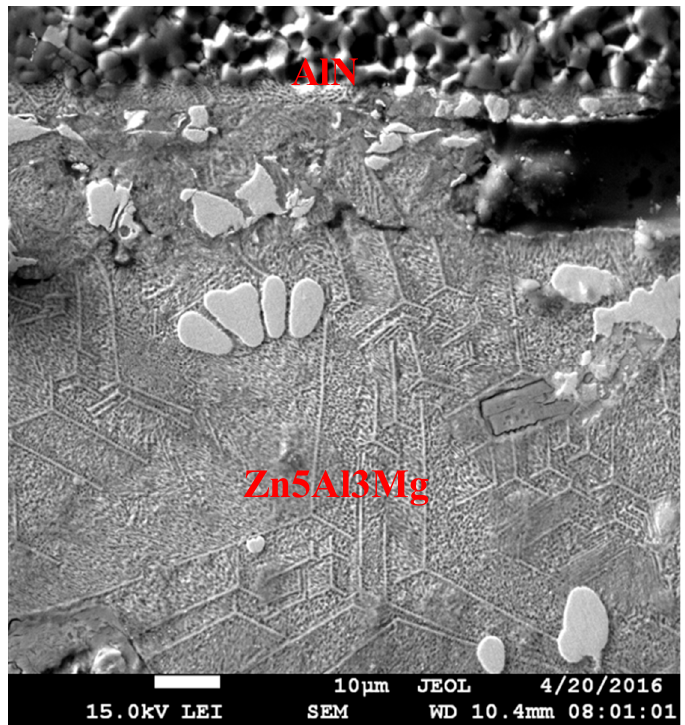
Figure 14. Microstructure of the AlN/Zn5Al3Mg boundary. Table 5. The phase composition results of AlN / Zn-Al-Mg joint